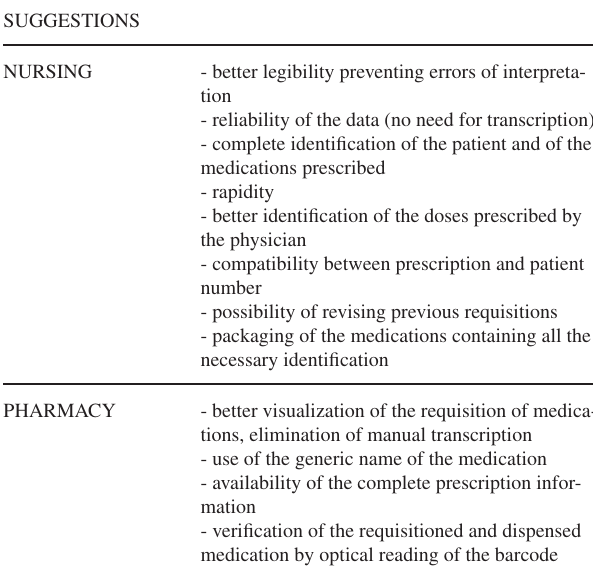
Table 3 - Suggestions for the reduction of errors in the administration of medications based on the informatized system,